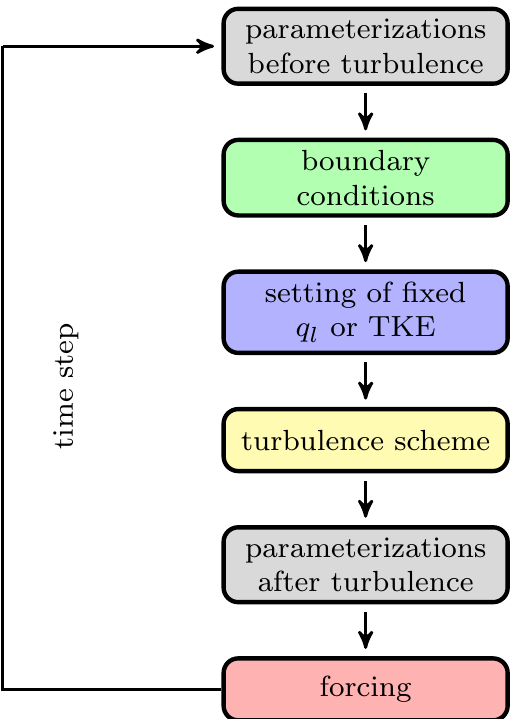
Figure 9. Schematic plot of fixing the vertical profile of q l or